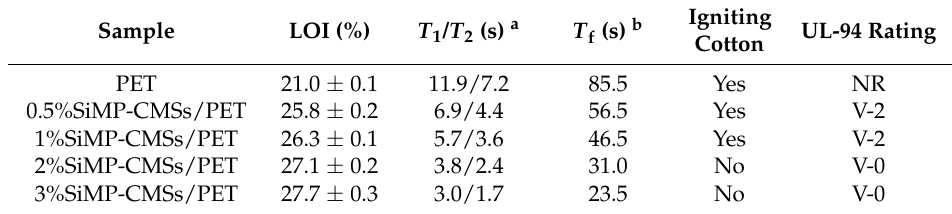
Igniting UL-94 Rating Cotton